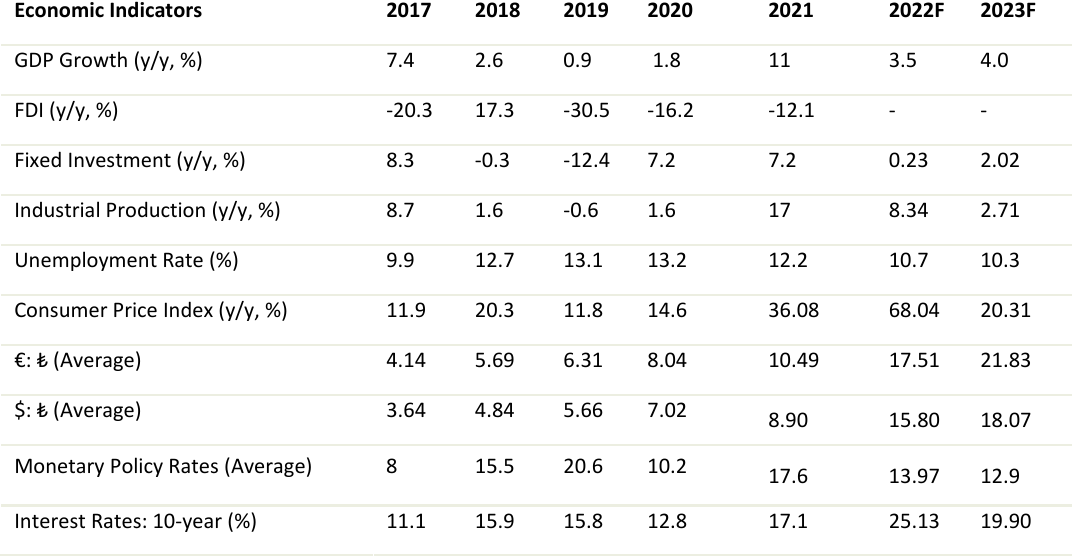
Table 1 Economic Summary, TURKSTAT and CBRT, 2022 F: Forecast Source: Moody’s